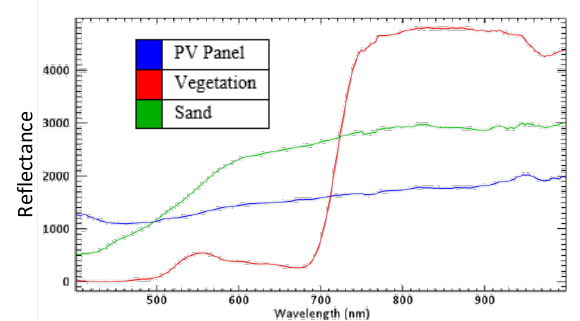
Figure 9: Library spectrum extracted from data for unmixing.